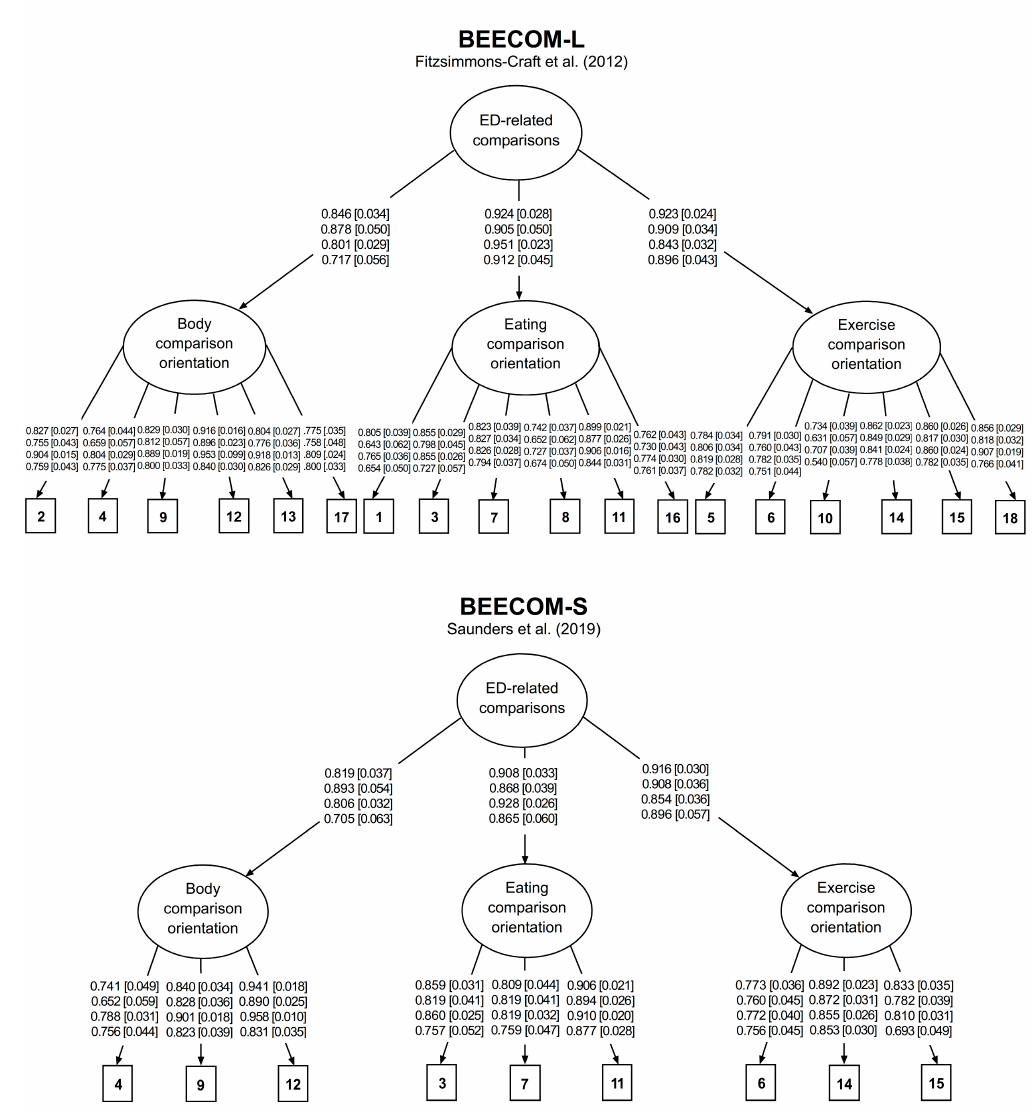
Figure 1. Factor structure for the long (BEECOM-L) and the short (BEECOM-S) versions of the Body, Eating, and Exercise Comparison Orientation Measure [16,17]. ED = eating disorders. The four rows of values correspond to the groups consisting of younger females, younger males, older females, and older males, respectively. Values outside square brackets represent standardized factor loadings ( λ ). Values inside square brackets represent standardized errors (SE).